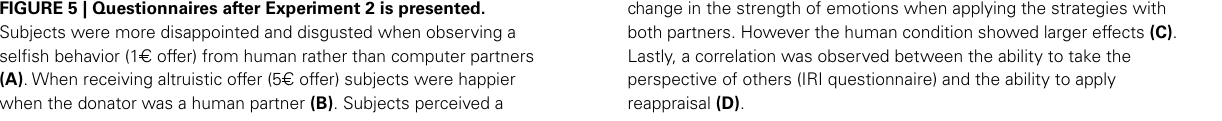
change in the strength of emotions when applying the strategies with both partners. However the human condition showed larger effects (C) . Lastly, a correlation was observed between the ability to take the perspective of others (IRI questionnaire) and the ability to apply reappraisal (D)